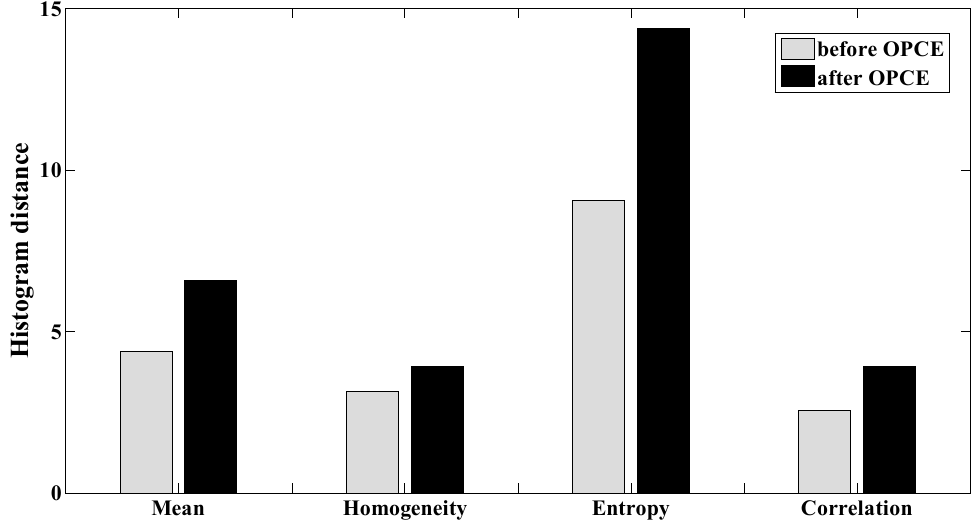
Figure 6. Bar chart of the histogram distance between CB and OB of the four texture features, before and after using the OPCE algorithm to enhance the contrast.